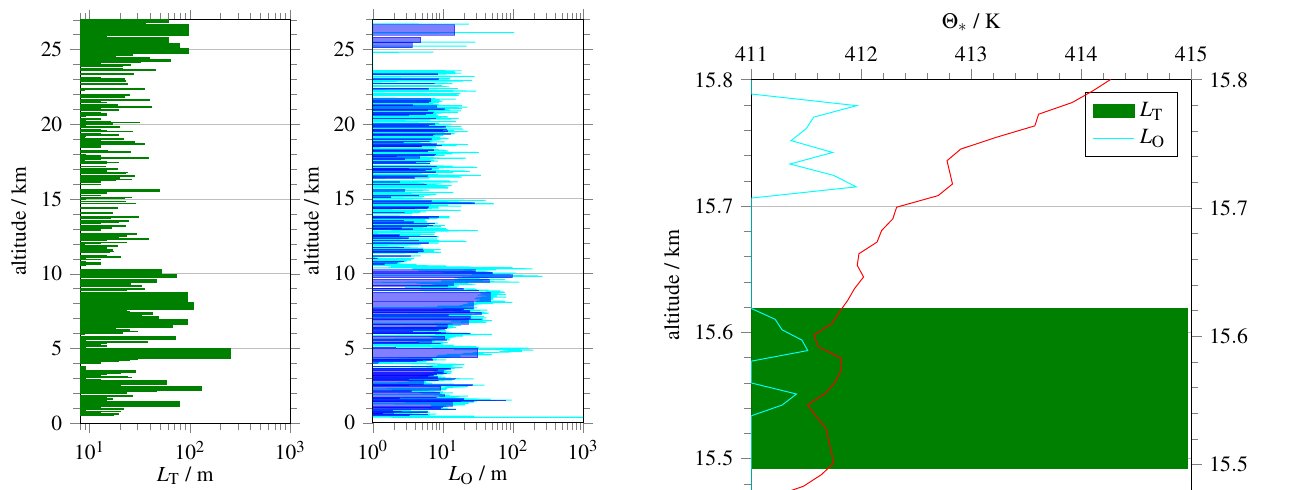
Figure 3. Thorpe length (left) and Ozmidov scale (right) vs. alti- tude for the detected inversions of the BEXUS 12 flight. In the right panel, the cyan curve shows the Ozmidov scale L O in the full res- olution of the LITOS profile, the blue bars visualise averages over the inversions detected by the radiosonde ( L O ).